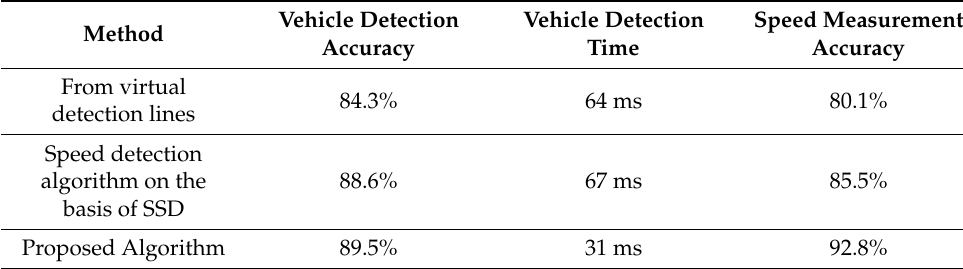
Table 5. Cloudy test